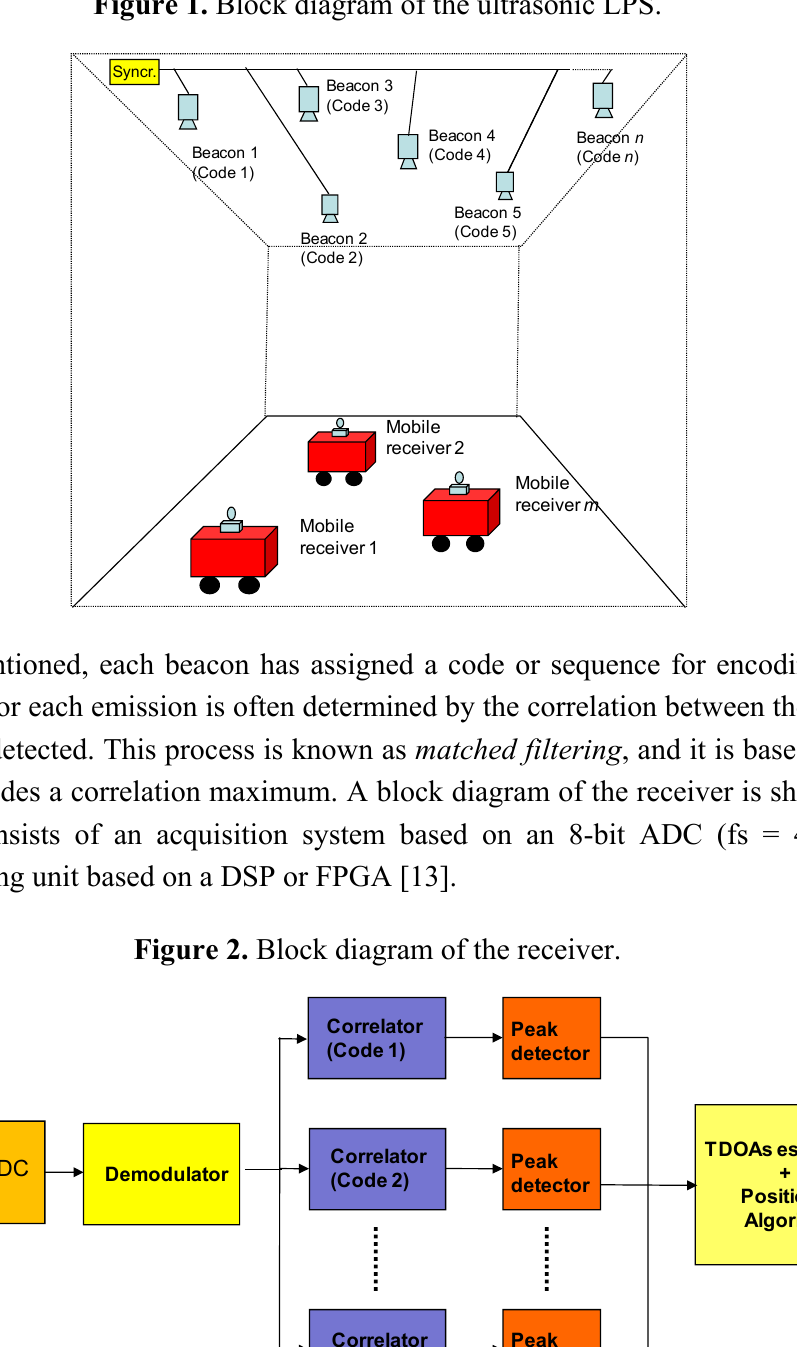
Figure 1. Block diagram of the ultrasonic LPS.